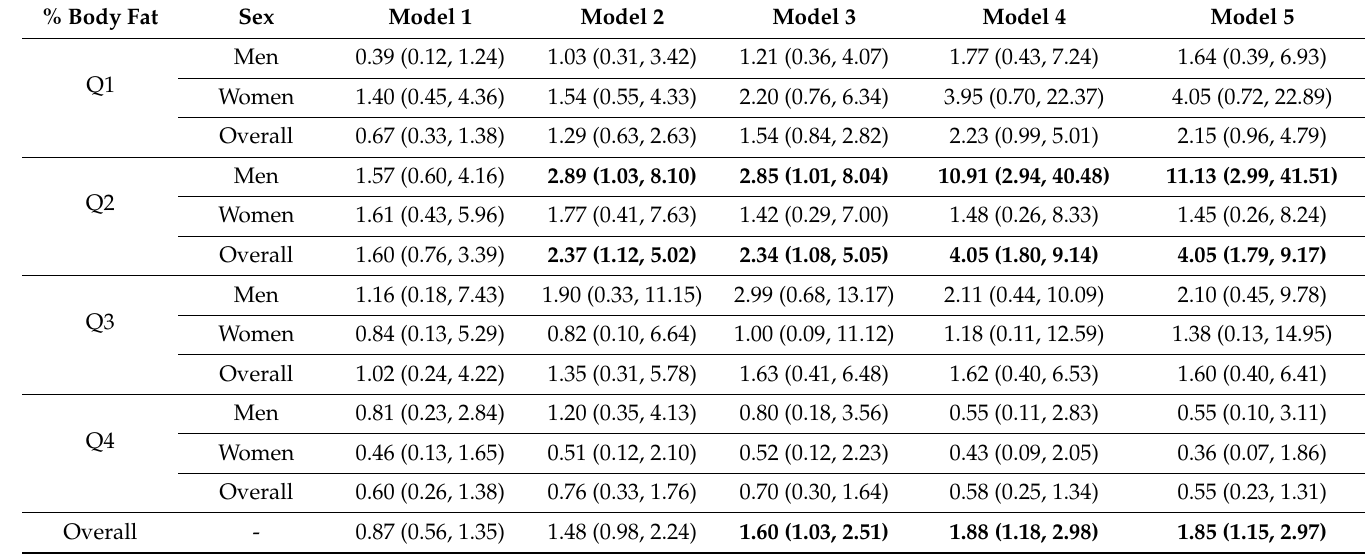
Table 2. Odds ratios for skipping breakfast by a one-unit increment in log-transformed leptin level (base 10), stratified by percent body fat, the National Health and Nutrition Examination Survey (NHANES) III,